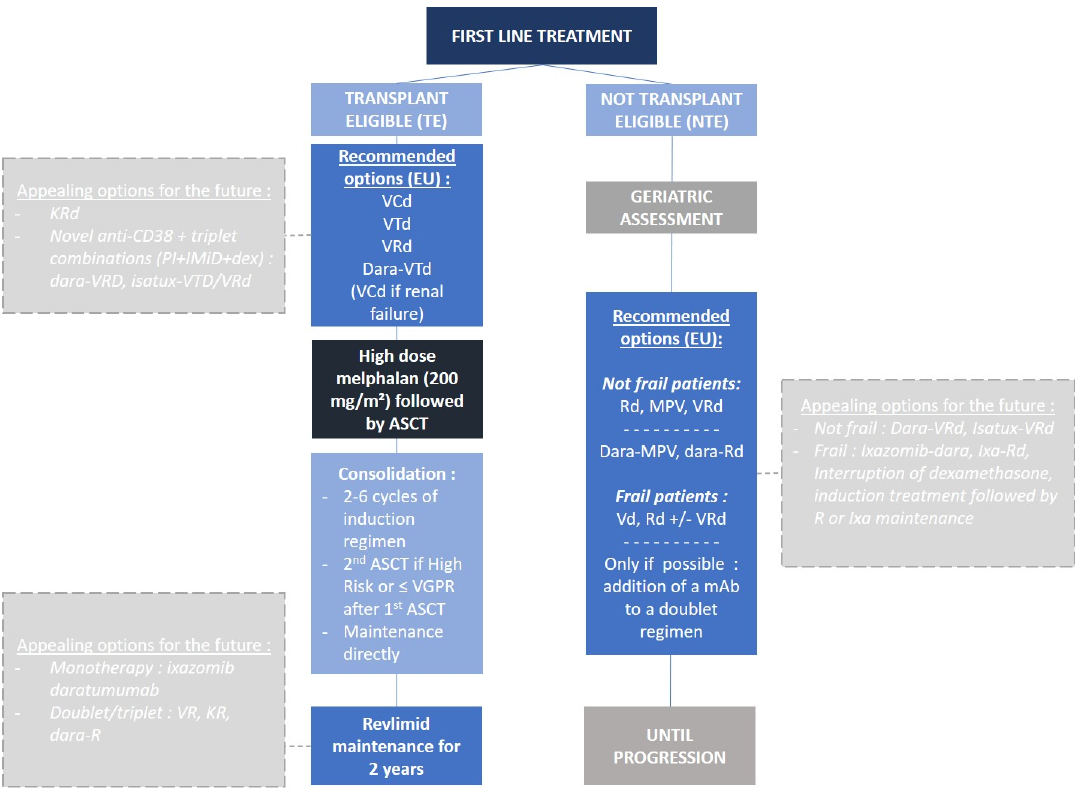
Figure 1. First-line treatment algorithm for transplant- and not transplant-eligible multiple myeloma Figure1. patients.